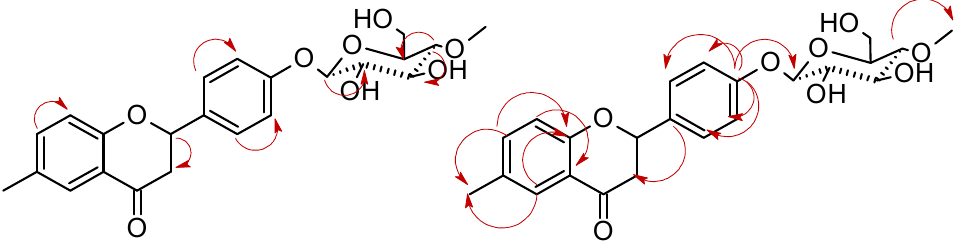
Scheme 10. Microbial transformation of 6-methylflavanone (4) in I. fumosorosea KCH J2 culture.